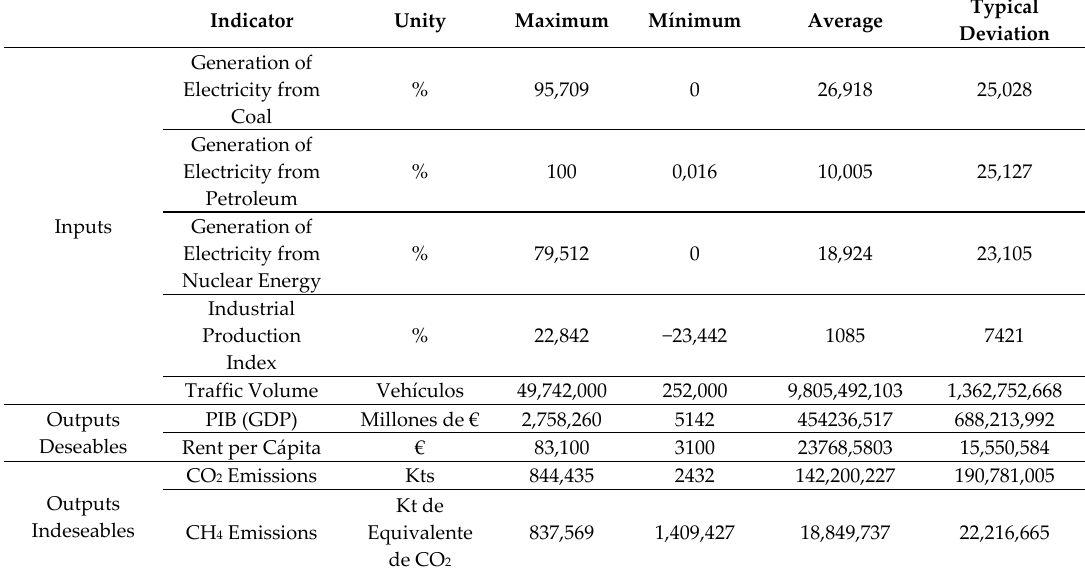
Table 2. Statistical study of inputs and outputs for 28 countries of the EU, 2005–2012. Source: self-made. Indicator Unity Average